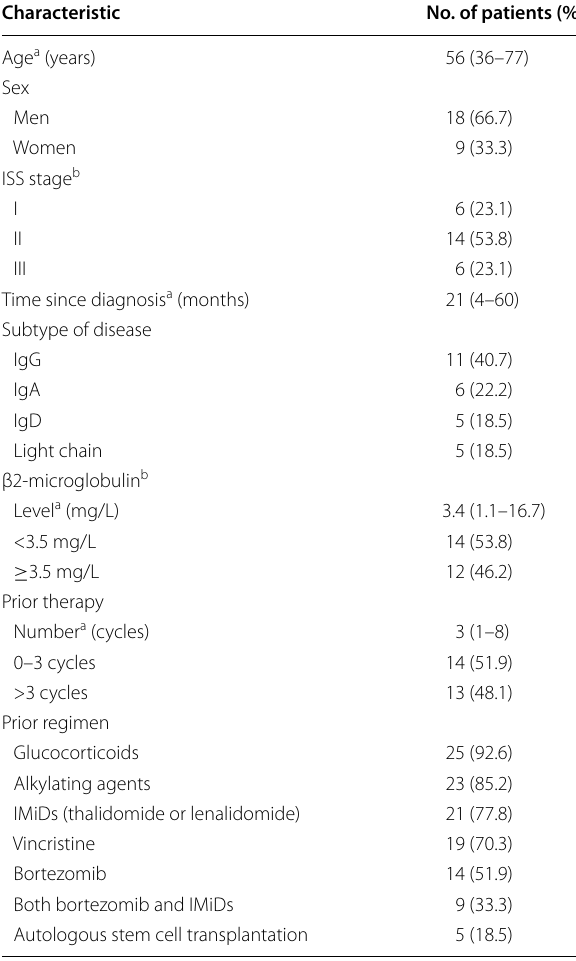
Table 1 Baseline characteristics of 27 patients with